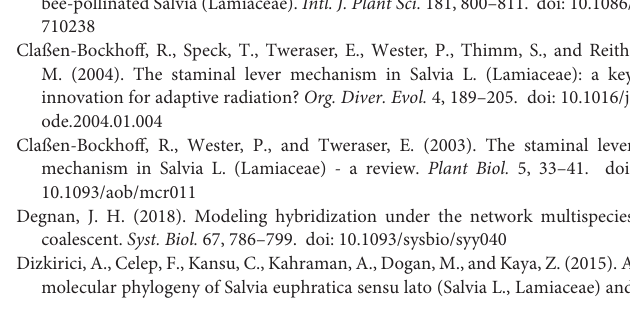
Supplementary Figure S1 | The ASTRAL species tree of Salvia and outgroups, with local posterior probabilities on branches. Ingroup branches are colored by subgenus. Supplementary Figure S2 | The ASTRAL species tree of Salvia and outgroups, with bootstrap support on branches. Ingroup branches are colored by subgenus. Supplementary Figure S3 | The RAxML maximum likelihood tree of Salvia and outgroups based on the concatenated nuclear matrix, with bootstrap support on branches. Ingroup branches are colored by subgenus. Supplementary Figure S4 | Phyparts summary of gene trees. Pies at major nodes summarize the percentage of various phylogenetic signals across 101 gene trees which can be rooted. The numbers at the left of the pies show the total number of gene trees in which the clade is found, followed by the total number of gene trees that conflict with that clade. The remainder of the gene trees, if any, do not provide information on that particular relationship. Ingroup branches are colored by subgenus. Supplementary Figure S5 | The RAxML maximum likelihood tree of Salvia and outgroups based on entire plastomes, with bootstrap support on branches. GenBank accessions are removed so that the plastome tree matches the nuclear tree in the tip composition. Ingroup branches are colored by subgenus. Supplementary Figure S6 | Tanglegram illustrating the disagreement between the ASTRAL (A) and concatenated maximum likelihood (B) species trees based on nuclear data. Links connect identical tips, with nodes rotated to minimize link overlap. Ingroup branches are colored by subgenus. Clades that differ between the two trees are indicated by filled circles on the concatenated maximum likelihood